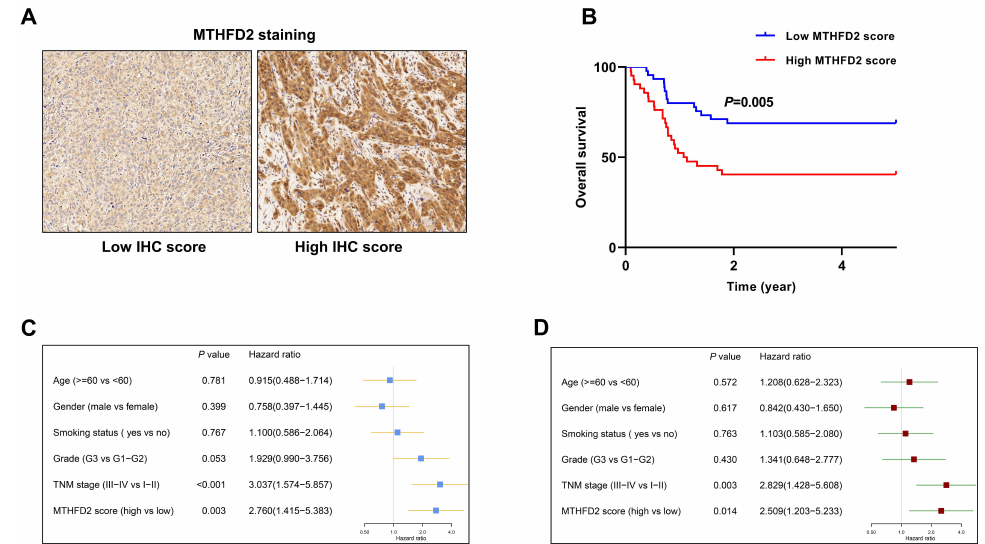
Figure 5. The prognostic value of MTHFD2 in HNSCC was validated in an independent cohort. ( A ) The representative samples in the high and low IHC score groups. ( B ) The patients in the high MTHFD2 score group had shorter OS than those in the low MTHFD2 score group. ( C ) Univariate analysis showed that MTHFD2 score was significantly associated with OS of HNSCC. ( D ) Multivariate analysis revealed that MTHFD2 score was an independent risk factor for HNSCC. Table1. The correlation betweenMTHFD2 stainingscoreand clinicopathologicalparameters of HNSCC. Variables Staining Score Min / Max p